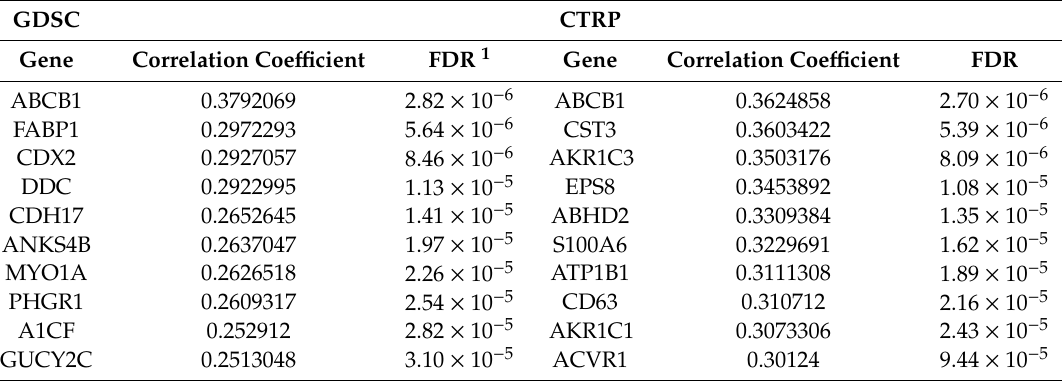
Figure 6. YM155 sensitivity in cancer cell lines characterized by high or low SLC35F2 expression based on the analysis of GDSC and CTRP data, both determined across all investigated cancer types / cell lines (GDSC, p < 0.001; CTRP, p < 0.001) and in a neuroblastoma-specific analysis (GDSC, p = 0.033; CTRP, p = 0.310). High SLC35F2 expression was associated with increased YM155 sensitivity, but the YM155 sensitivity of individual cell lines could not be predicted based on their SLC35F2 levels. Table 1. Top 10 genes whose expression is most strongly correlated with the YM155 AUC in the Genomics of Drug Sensitivity in Cancer (GDSC) database and the Cancer Therapeutics Response Portal (CTRP) as indicated by the Pearson correlation coefficient.